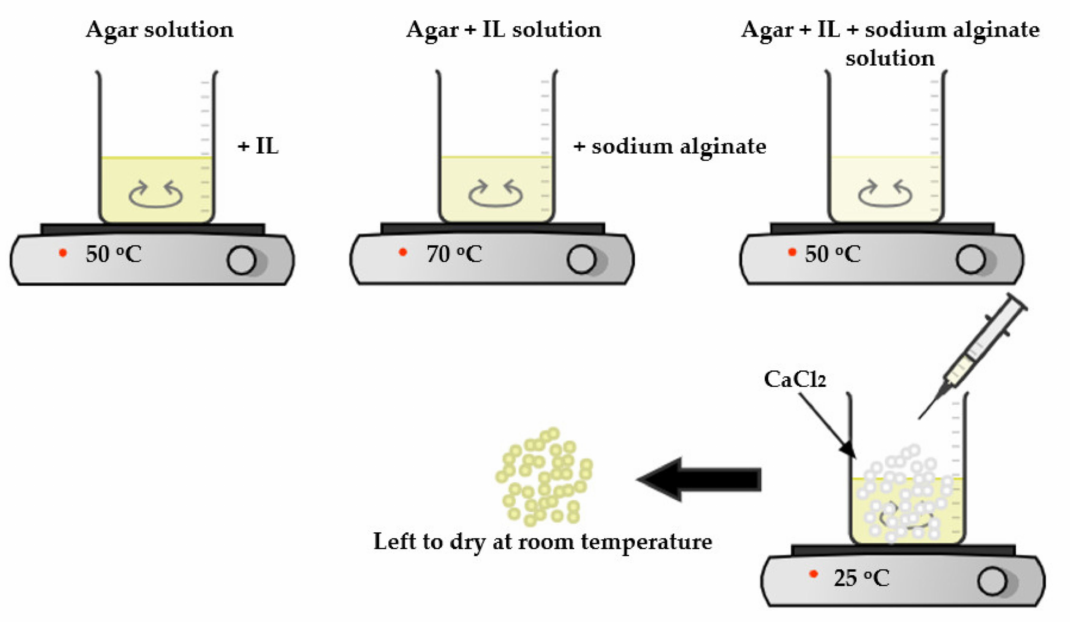
Figure 2. Schematic diagram for IL–agar–alginate beads preparation.